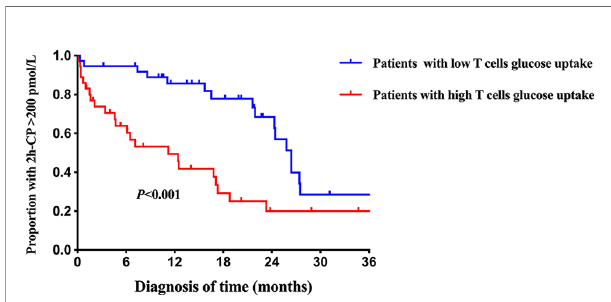
FIGURE 5 | Survival curves of beta-cell preservation in T1D patients with different intracellular T cell glucose uptake status. The blue line = patients with low T cells glucose uptake, red line = patients with high T cells glucose uptake. 2h-CP>200 pmol/L as de fi ned as beta-cells preservation. Log-rank survival analysis is used. 2h-CP, 2 hours postprandial C-peptide.